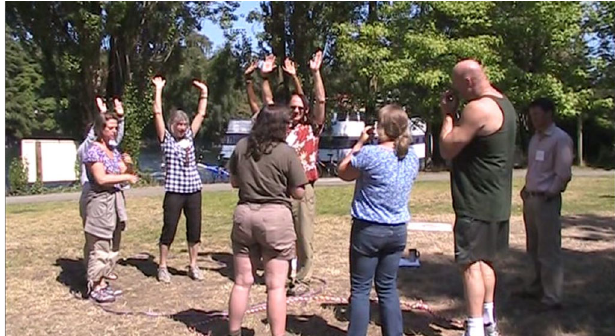
FIG. 2. Teachers in a secondary science professional develop- ment course perform Energy Theater for the lowering